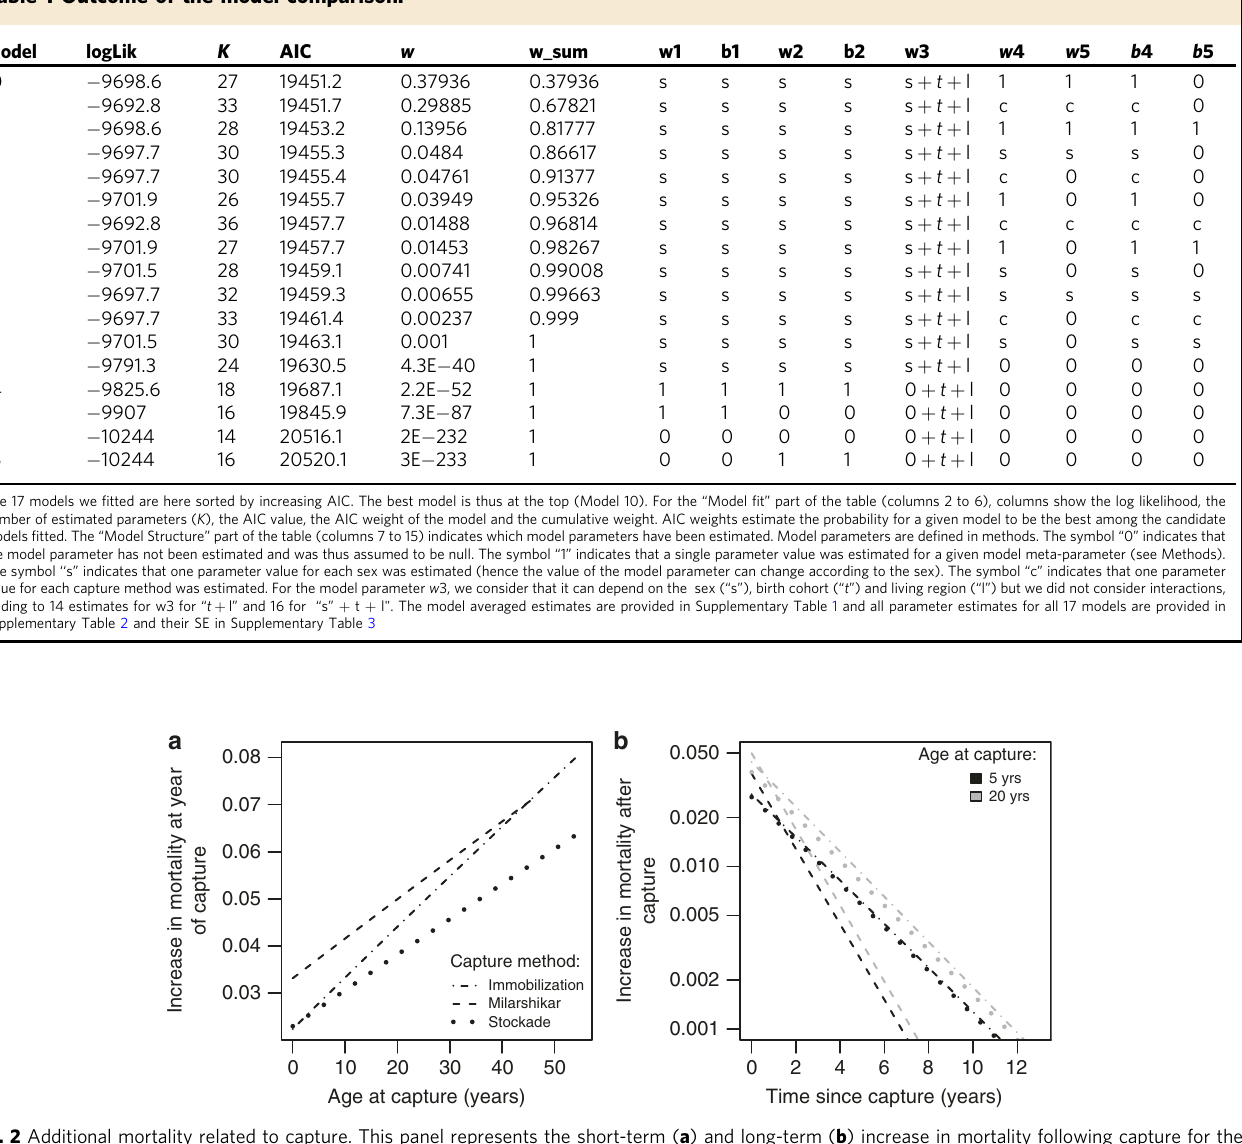
Fig. 2 Additional mortality related to capture. This panel represents the short-term ( a ) and long-term ( b ) increase in mortality following capture for the three capture methods. Lines depict predictions from model averaging of all model fi ts presented in Table 1. Here, predictions would be identical for different birth cohorts and living regions, and although predictions are here computed for males they are virtually identical for both sexes (not shown). Short-term effect refers to the increase in mortality from the baseline level for the year following capture. This does not consider the immediate